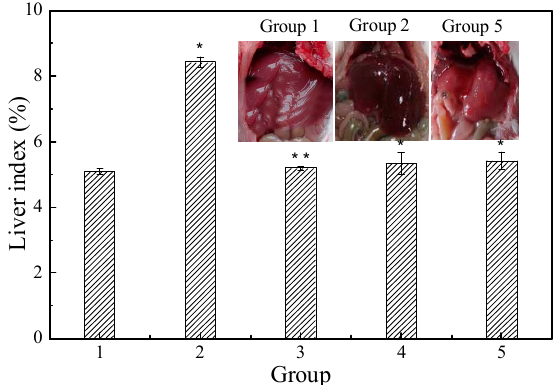
Figure 7. Liver index of Kunming mice (KM) mice under toxic experiment ( n = 10). Asterisk denotes a response that is significantly different from the control (* p < 0.05, ** p < 0.01).